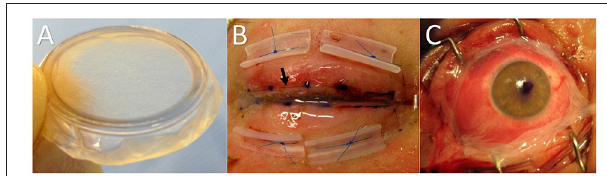
FIGURE 2 | (A) Prokera self-retaining amniotic membrane. Useful only when bulbar conjunctival sloughing is limited. Amniotic membrane grafting to the lid margins and palpebral conjunctiva is still necessary even when a Prokera has been used on the surface of the globe. (B) Lid margin and palpebral conjunctival amniotic membrane. The black arrow shows the running 8–0 nylon suture 1–2mm peripheral to the lid margin. Once fixated to the external lid skin by the 8–0 nylon, the membrane is reflected over the lid margin and onto the palpebral conjunctiva where it is fixated with a pair of double-armed 6-0 polypropylene sutures. Both needles of each suture are passed full-thickness through the membrane and the eyelid and then tied externally over bolsters. (C) SJS patient with significant bulbar conjunctival sloughing treated with a sheet of cryopreserved amniotic membrane rather than a Prokera. The running perilimbal 10-0 nylon suture and oblique quadrant interrupted sutures have not yet been